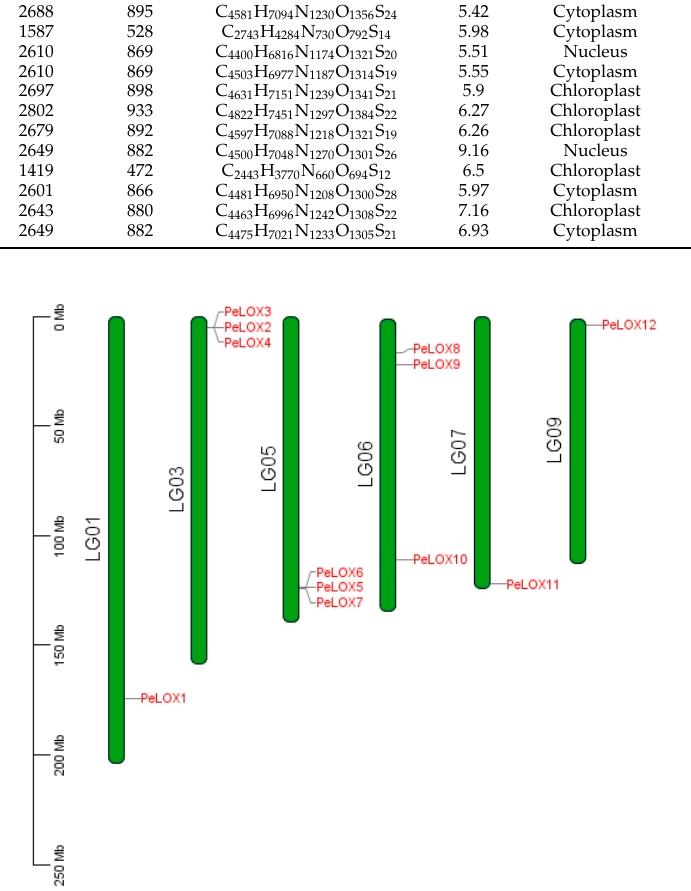
Figure 1. Distribution of PeLOX family on Passiflora edulis chromosomes.